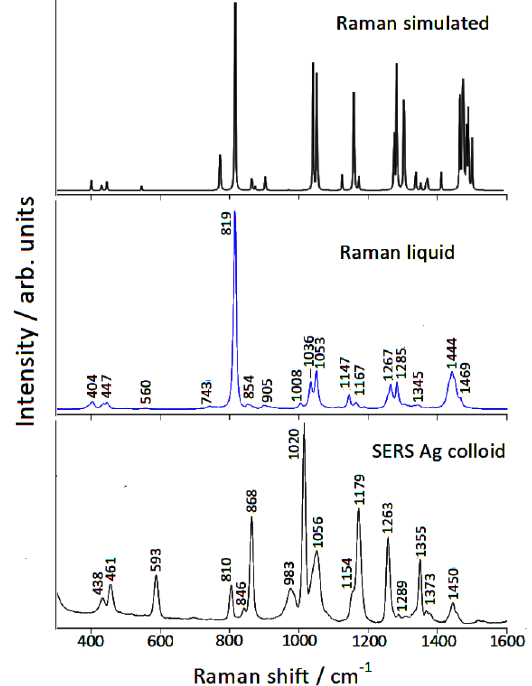
Figure 2. Raman spectra of piperidine.